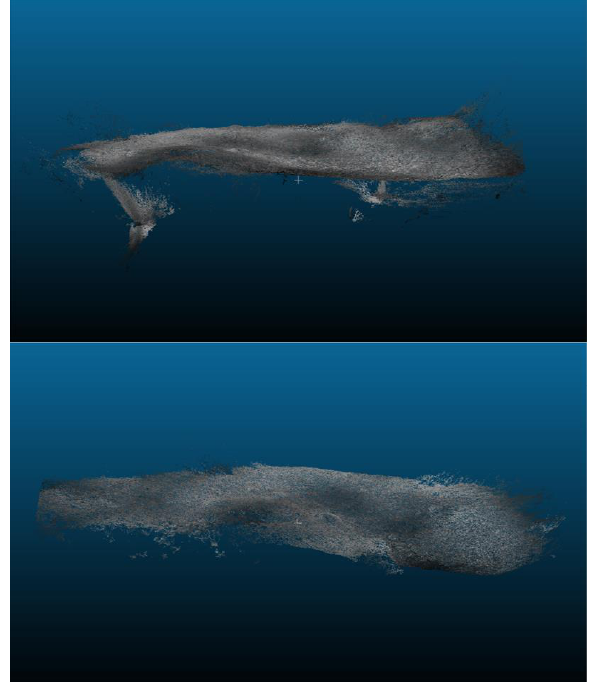
Figure 3. Dense models of A-3 (top) and A-4 (bottom)